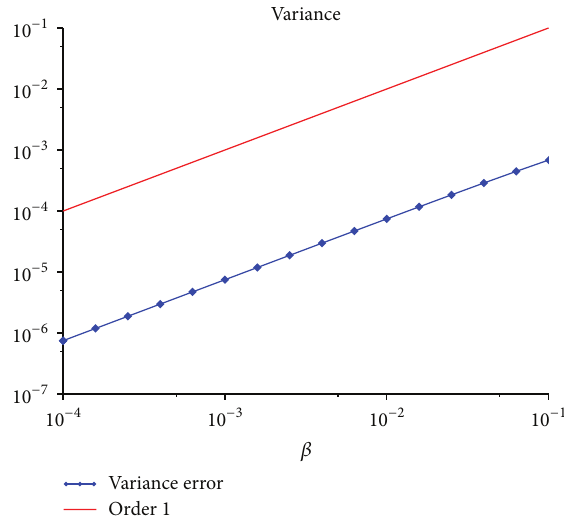
Figure10:Log-Logscaleplotofthevarianceabsoluteerrorof 𝑅 (𝑝=15) 𝑇 at 𝑇 = 1 for different 𝛽 = 10 −[1:0.2:4] compared with order 1. The other parameters of the Vasicek interest model are 𝛼 = 0.1 , 𝜎 = 0.15 , and initial value 𝑅 0 = 110